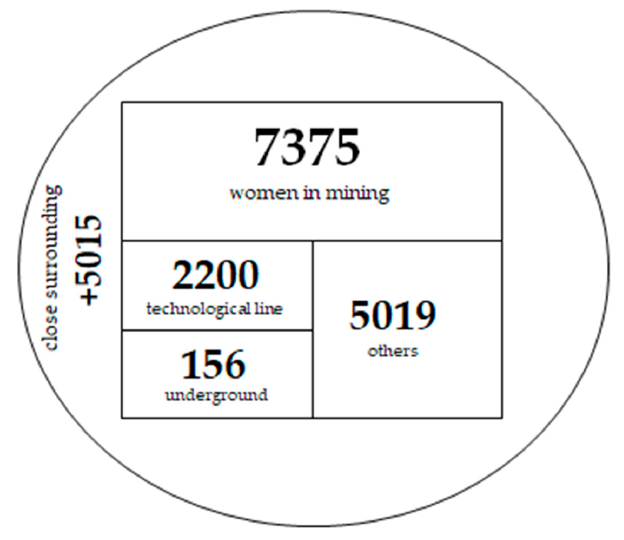
Figure 7. Number of women employed in mining, based on GUS, women, and men in the labor market (2004–2018).